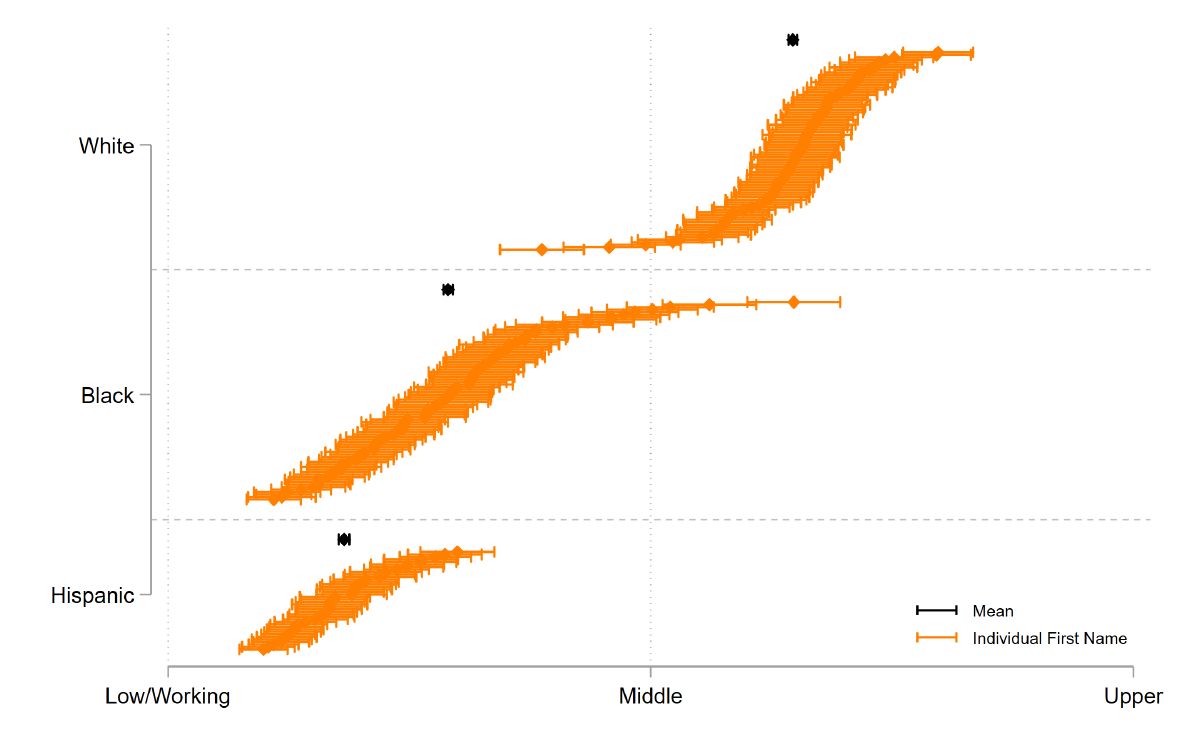
Figure 4: Heterogeneity in social class perceptions by first names. Note: Data from Study 4. This plot shows respondent perceptions of social class based on names intended to signal different racial/ethnic categories. Plotted points denote predictions and bars represent 95 percent confidence